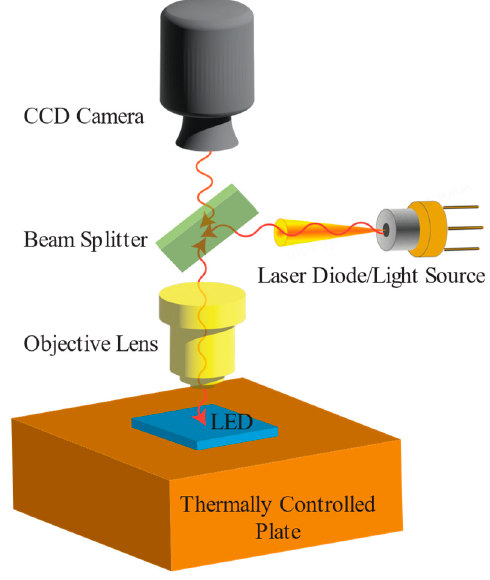
Figure 6. Schematic of a typical measurement arrangement and experimental apparatus used for the thermoreflectance setup.